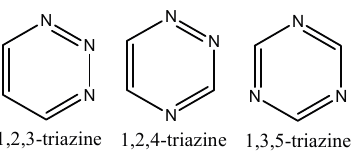
Figure 1. Basic skeleton of different types of